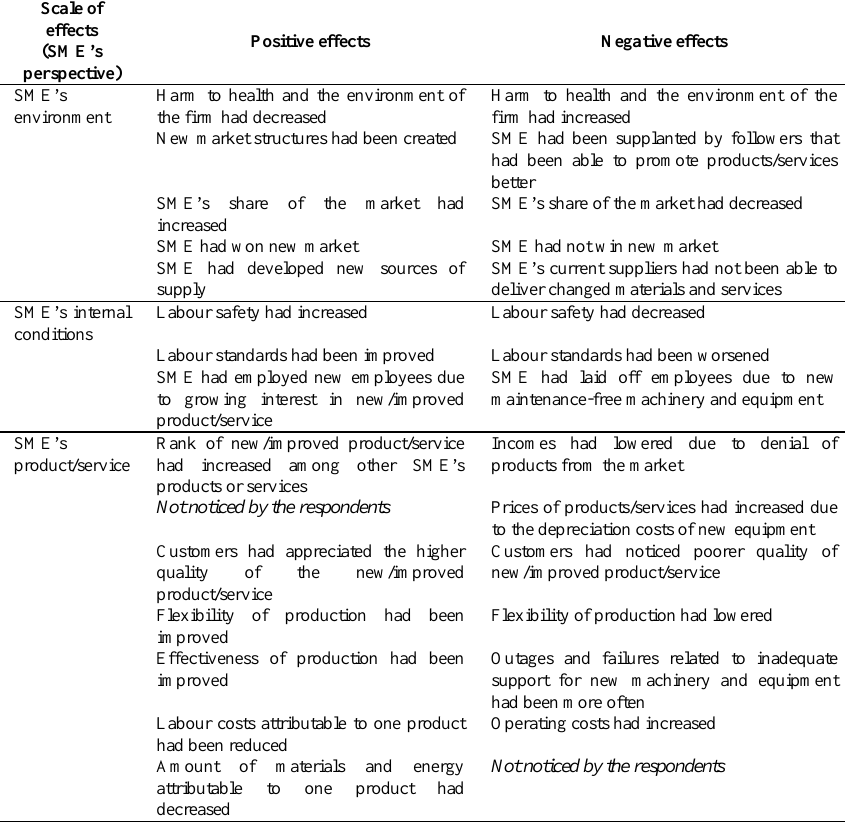
Table 2. The model of possible innovation effects Scale of